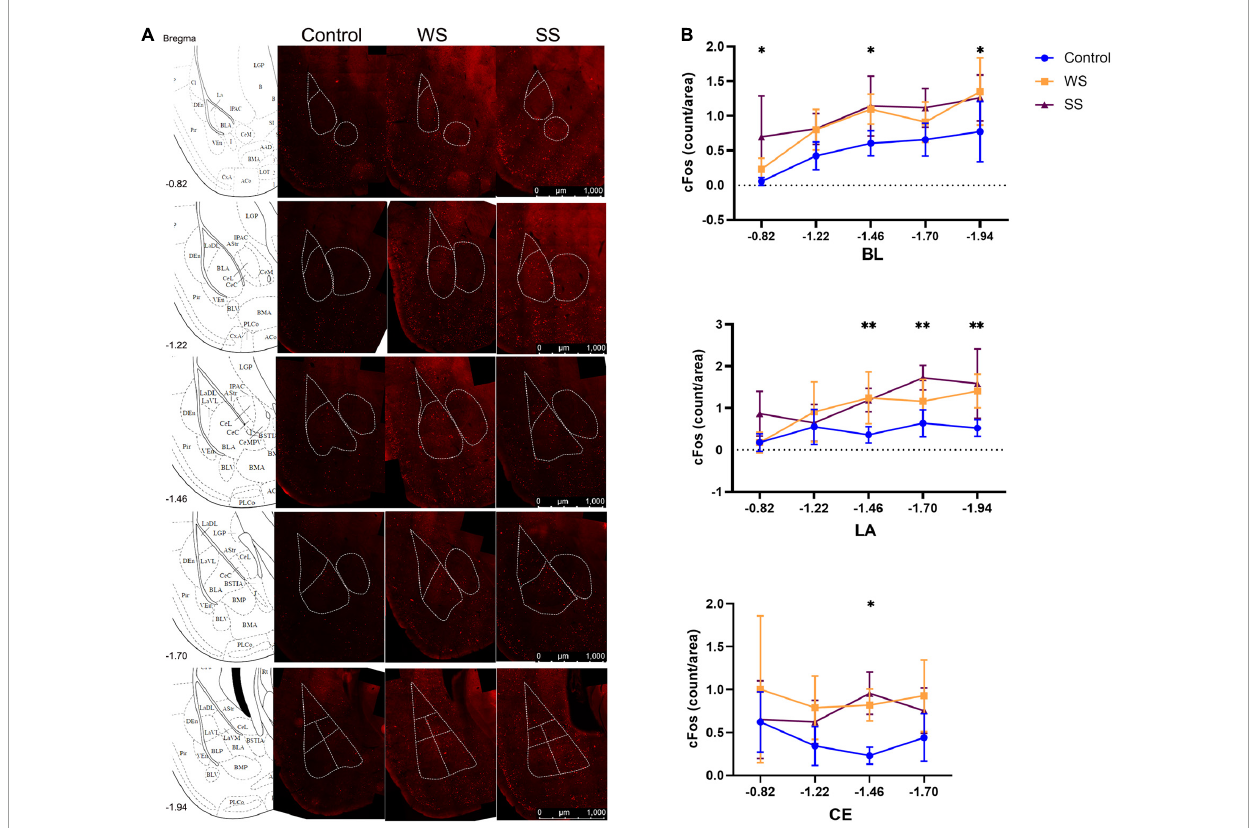
FIGURE2 c-Fos + cells in amygdala after fear conditioning. (A) c-Fos immunofluorescent in the amygdala (4 mice in each group). (B) c-Fos + cells density in amygdala increased after fear conditioning (two-way ANOVA, Tukey’s multiple comparisons test, BL: F 2 , 9 = 18.34, p < 0.0001, ∗ p [ - 0 . 82 , Control vs ∗ p [ ∗ p [ ∗ p [ ∗∗ p [ - 1 . 46 , control vs WS ] = 0.0491, - 1 . 46 , control vs SS ] = 0.0115, - 1 . 94 , control vs WS ] = 0.0221; LA: F 2 , 56 = 18.45, p < 0.0001, - 1 . 46 , SS ] = 0.0275, ∗∗ p [ ∗∗ p [ ∗∗ p [ ∗∗ p [ - 1 . 46 , control vs SS ] = 0.0028, - 1 . 70 , control vs SS ] = 0.0027, - 1 . 94 , control vs WS ] = 0.0069, - 1 . 94 , control vs SS ] = 0.0010; control vs WS ] = 0.0053, CE: F 2 , 45 = 10.42, ∗∗ p = 0.0002, p [ - 1 . 46 , control vs WS ] = 0.0073, ∗∗∗ p [ - 1 . 46 , control vs SS ] =